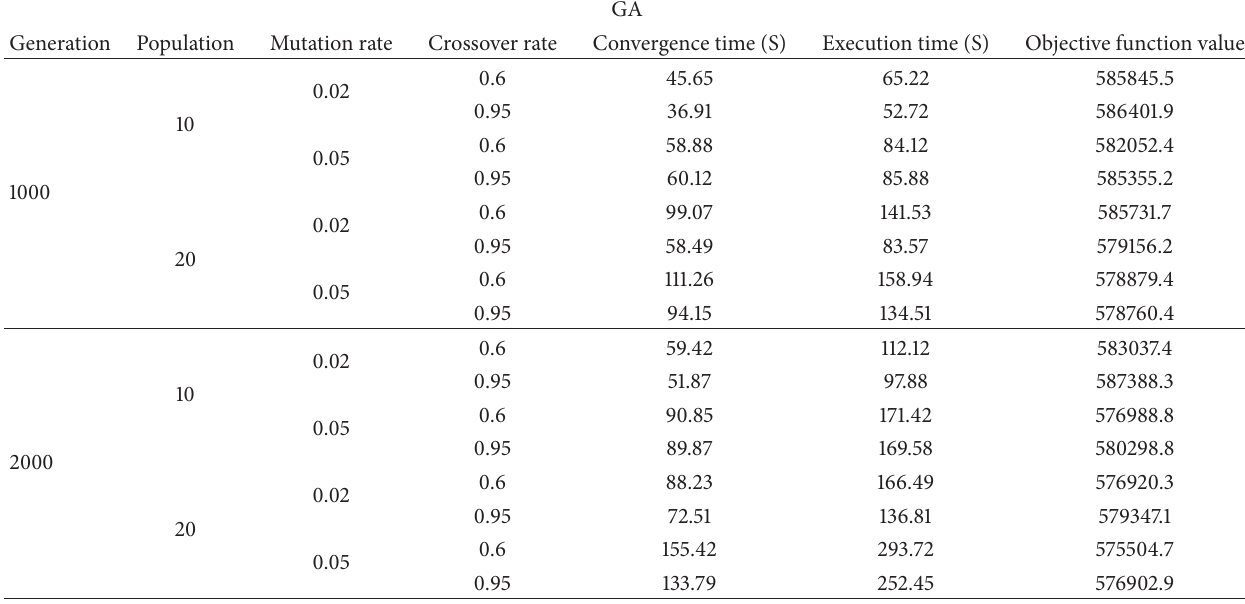
Table 2: Experimental design results of GA with different groups of parameters.